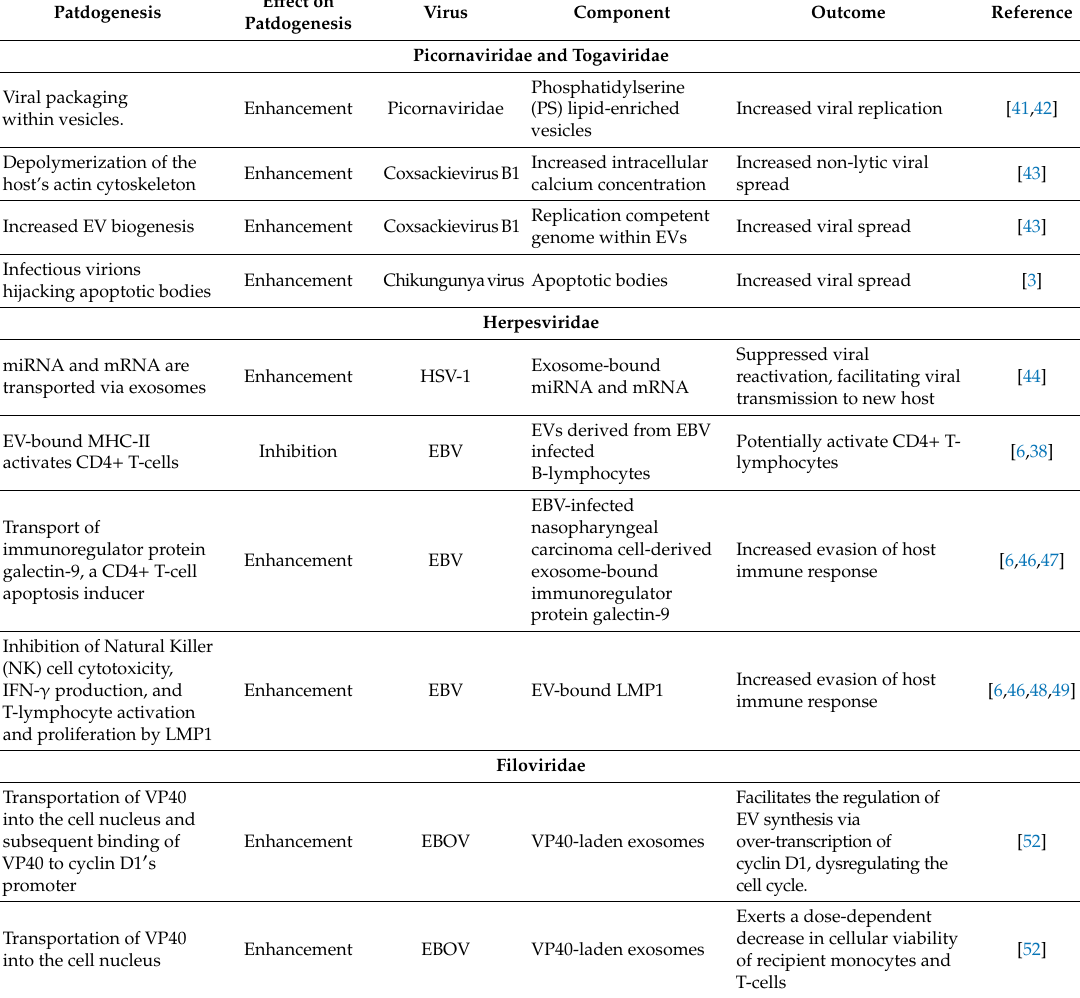
Table 1. Summary of EV-mediated e ff ect in viral